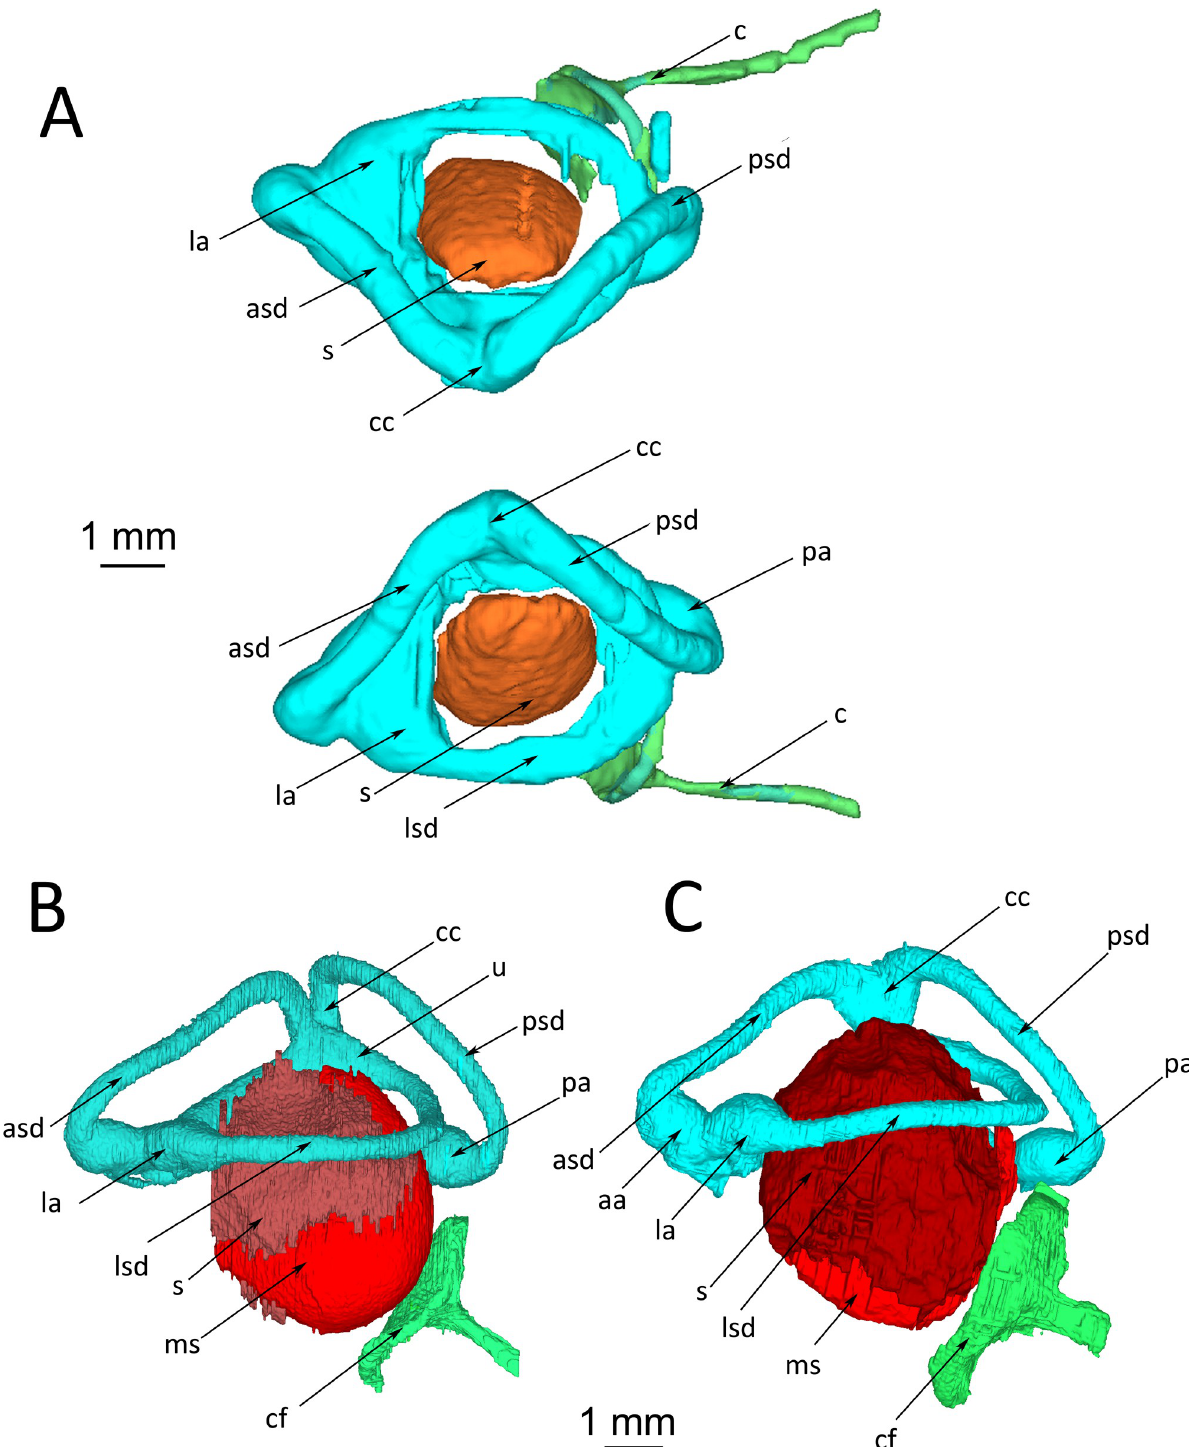
Fig 2. Python regius , orthographic projections of 3D-reconstructions of the membranous inner ear of wildtype ball pythons. (A) Dorsal view of both inner ears of snake #P14. The reconstruction is based on lower resolution scans of the entire head; therefore, making the reconstruction less sharp than the high-resolution scans in (B) and (C). (B) Right ear, control animal #1. (C) Right ear, control animal #2. For easy comparisons, images (B) and (C) have been mirrored so that left is rostral and right is occipital. Abbreviations: aa, anterior ampulla; asd, anterior semicircular duct; c, columella; cc, crus communis; cf, columella footplate; la, lateral ampulla; lsd, lateral semicircular duct; ms, macula sacculi; pa, posterior ampulla; psd, posterior semicircular duct; s, sacculus; u, utriculus.